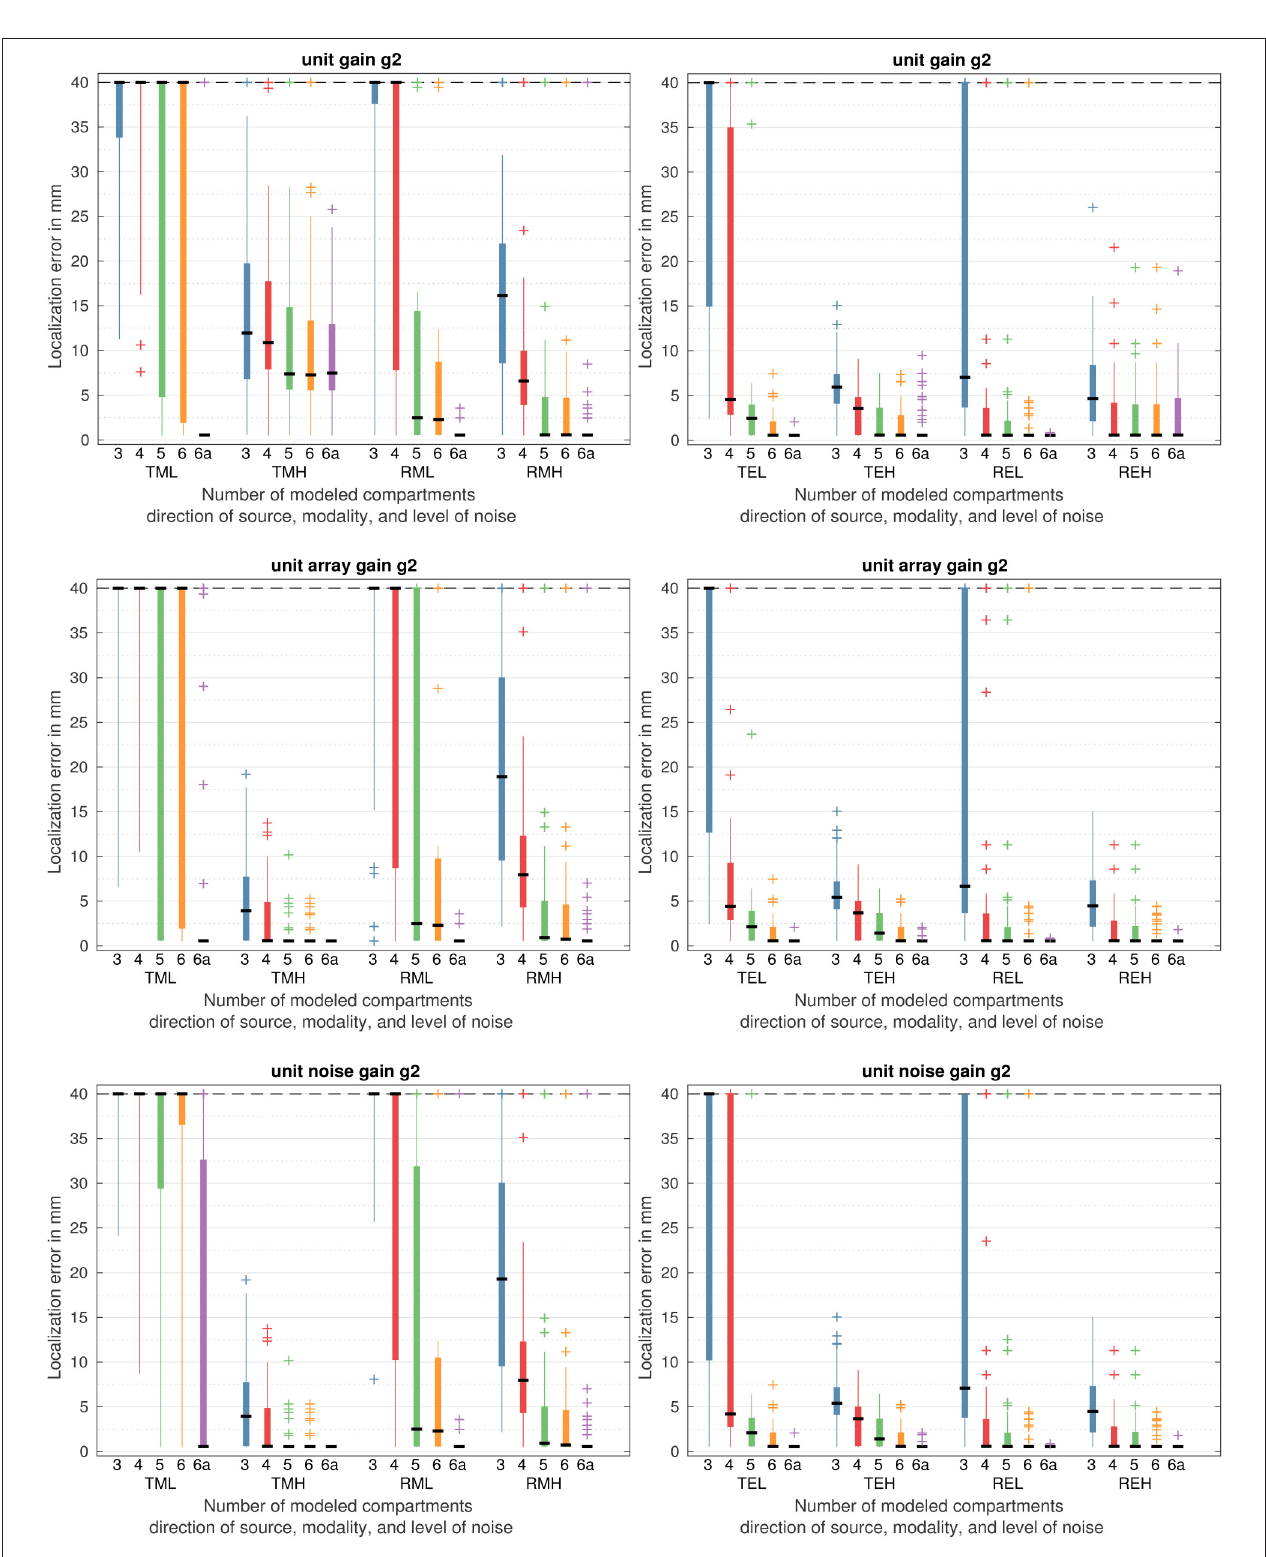
FIGURE 6 | Localization errors based on the kurtosis beamformers output for all head models. On the left side for MEG, right side for EEG. T for quasi-tangential, R for quasi-radial sources, L for low noise, H for high noise, M for MEG simulation, E for EEG simulation. Please refer to Table 1 for an overview of the models.